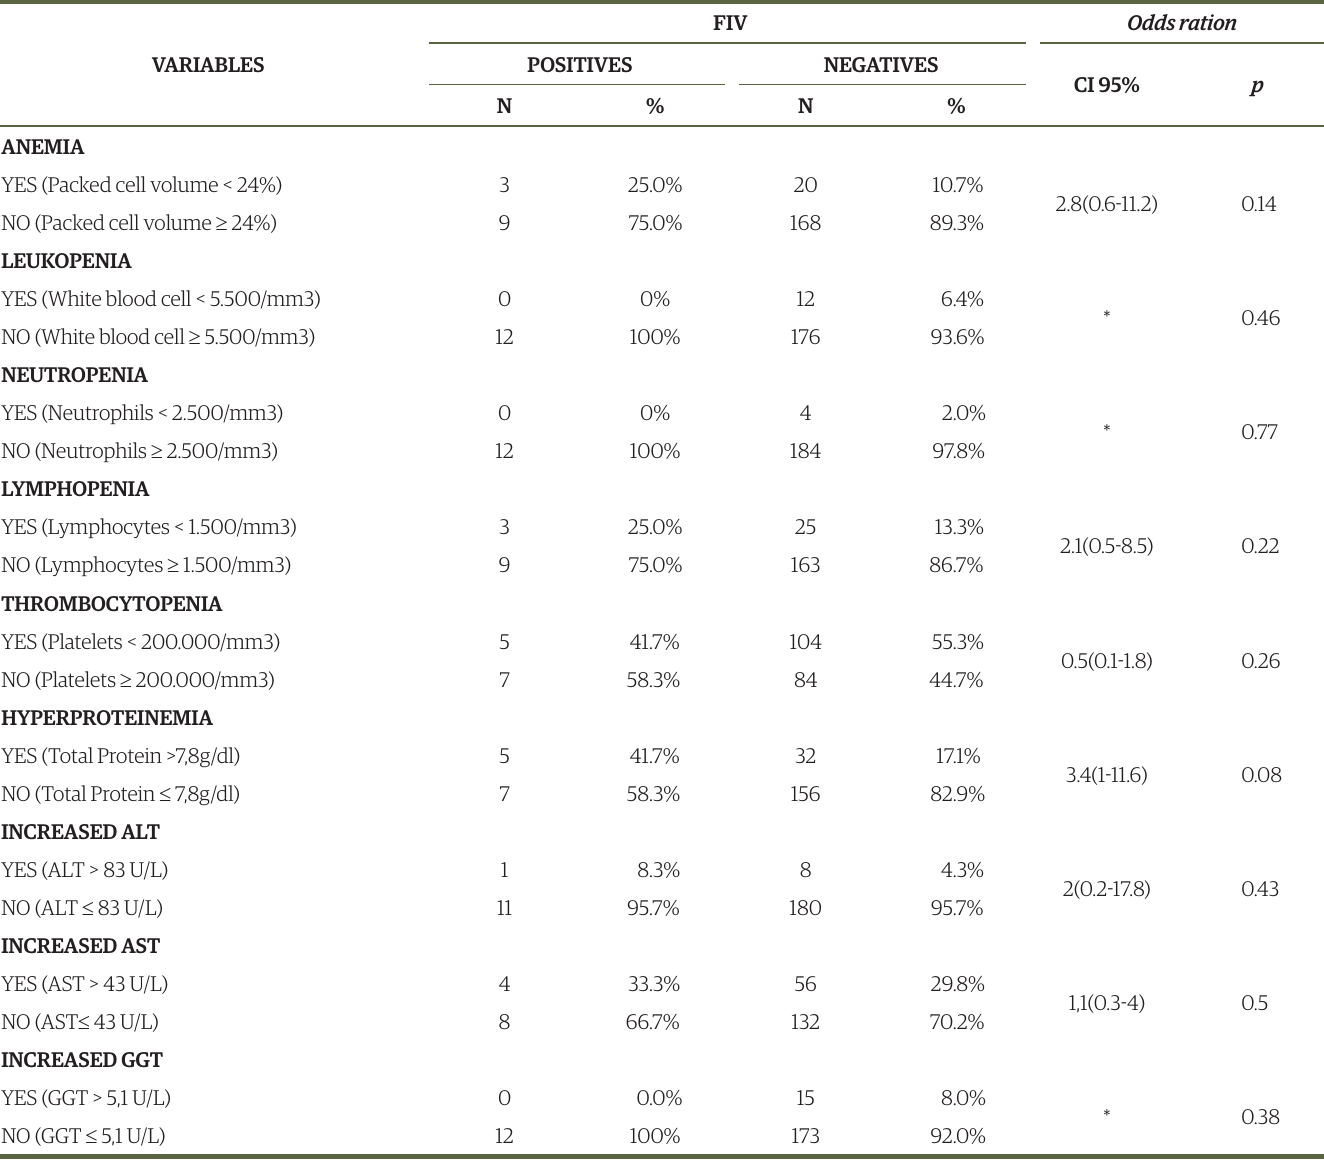
Table 2. Contingency tables for hematological and biochemical variables categorized with FIV status.